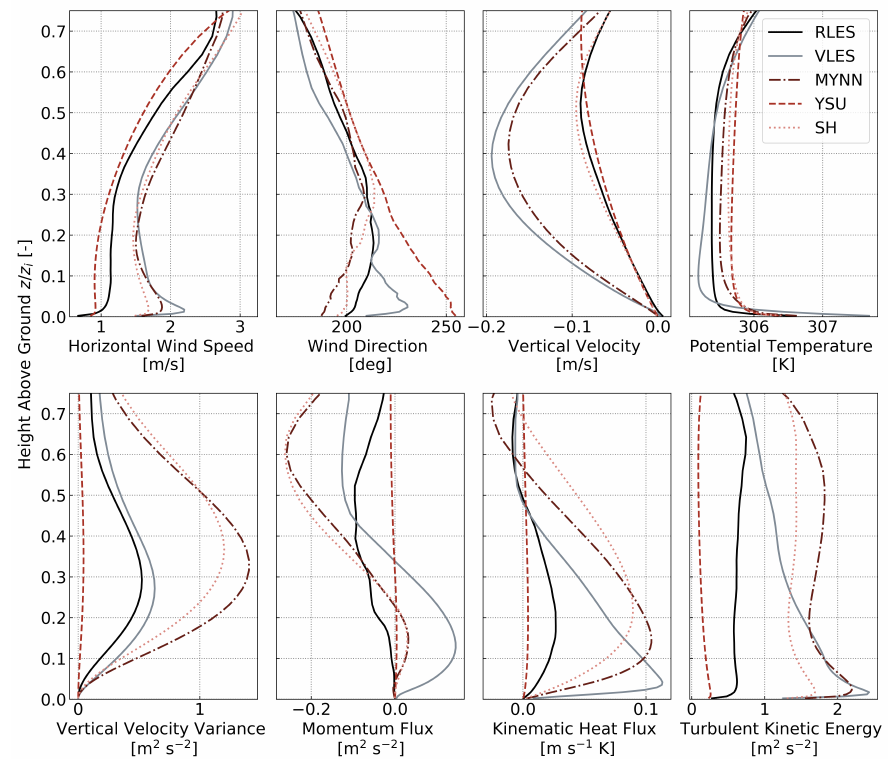
Figure 16. Vertical profiles of horizontally averaged quantities between 0 > z / z i < 0.75 on 21 March, 2100 UTC (1500 LT). This time represents a peak in − z i / L , as shown in Figure 4d. Horizontal averages consider an area that extends 15 km × 15